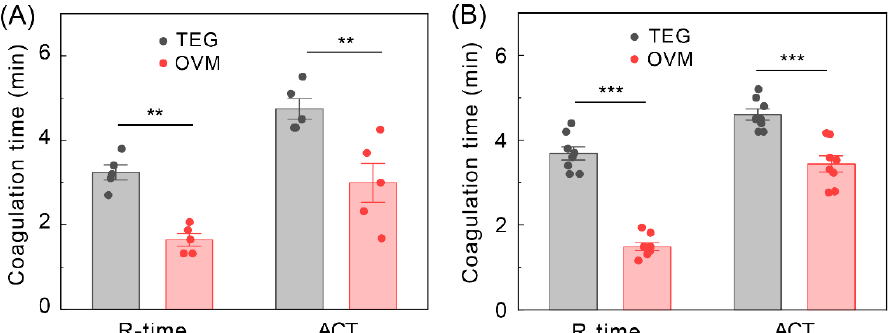
Figure 5. Coagulation profiles of blood with the same initial coagulation conditions. ( A ) Blood anticoagulated with sodium citrate. The analyzed blood samples with different storage times, 2~14 days, n = 5. ( B ) Blood anticoagulated with sodium heparin. The analyzed blood samples with different storage times, 2~22 days, n = 8. Mean ± SD. ** p < 0.01, *** p < 0.001; two-way ANOVA followed by Tukey post hoc test.